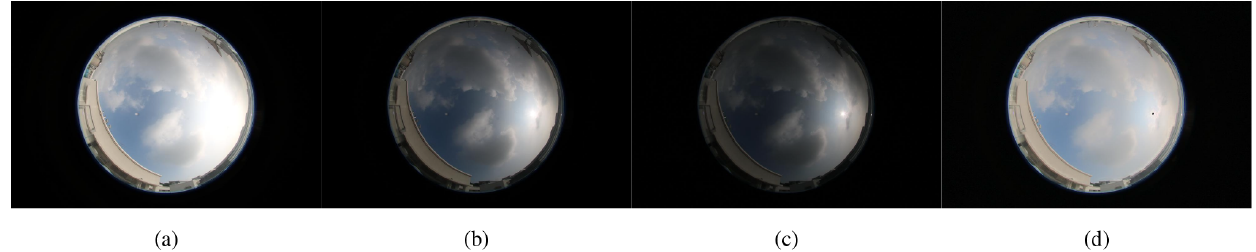
Figure 2. Example of three images captured by the camera at varying exposure levels and shutter speeds: (a) 0EV, 1/400s; (b) − 2EV, 1/1600s; (c) − 4EV, 1/4000s. (d) HDR image computed by fusing the pictures (a–c) (tone-mapped for visualization